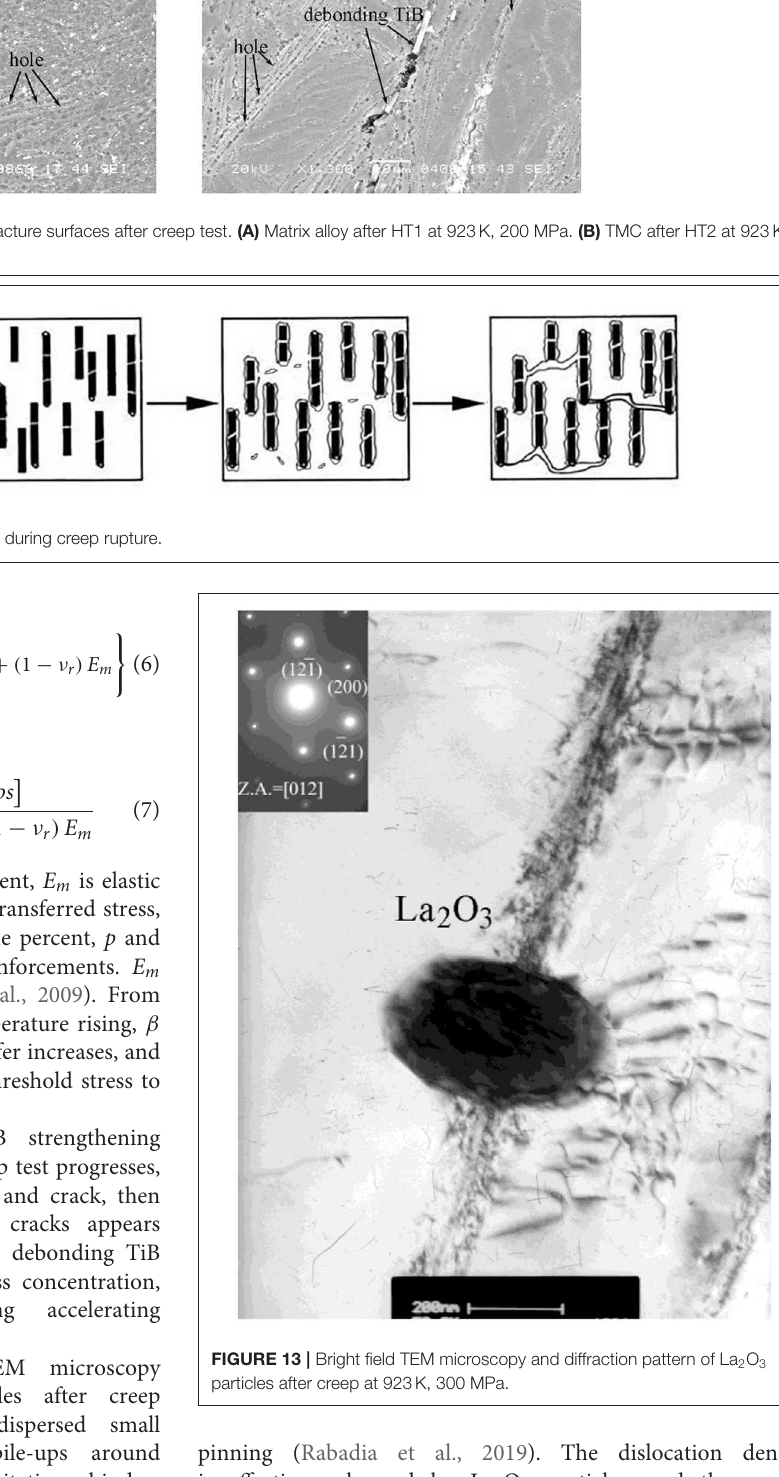
pinning (Rabadia et al., 2019). The dislocation density is effective enhanced by La 2 O 3 particles, and then creep resistance improved, which is explained by Orowan